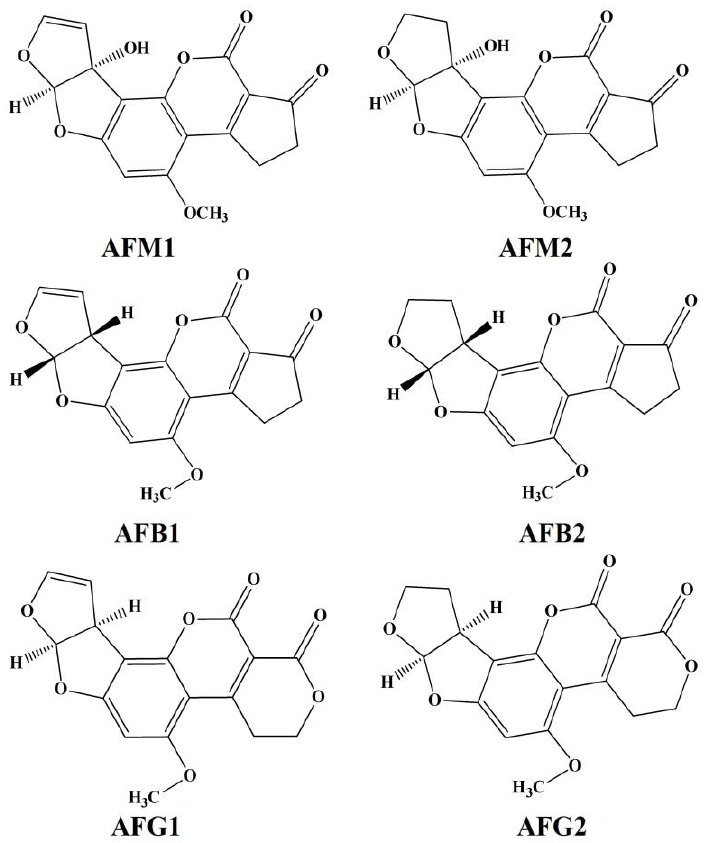
Figure 1. Structure of commonly found aflatoxins (AFs).